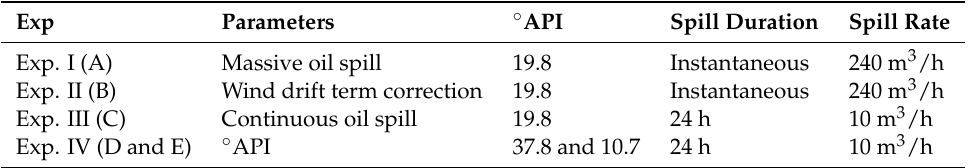
Table 1. The table summarizes the numerical experiments. The second column highlights the impact of the initial conditions on the evolution of the oil spill concentration and Oil Fate Parameters (OFP). The third column indicates the ◦ API, the fourth the spill duration and the fifth the spill